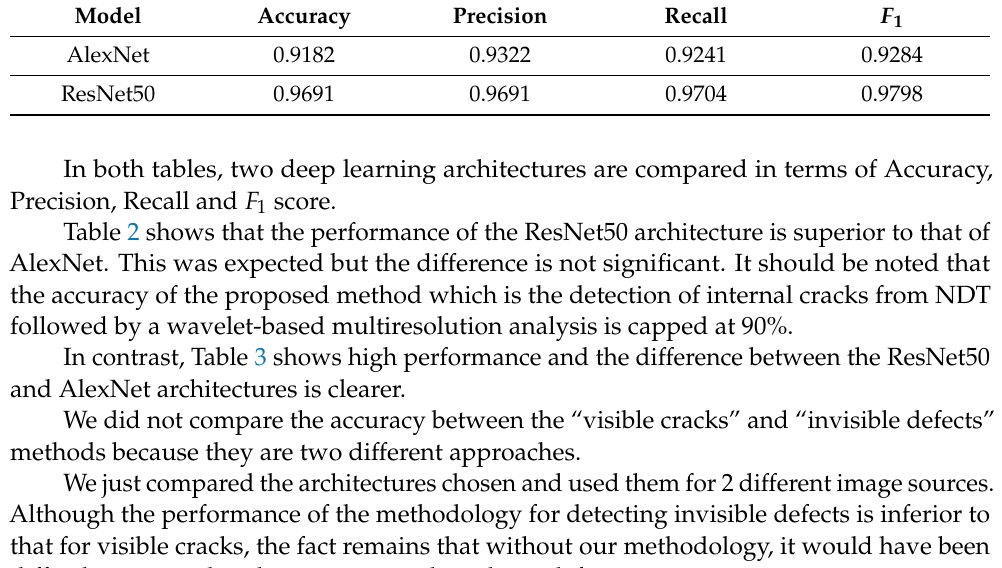
Table 3. SDNET2018: Comparison of two model’s crack detection results. Model Accuracy Precision Recall F